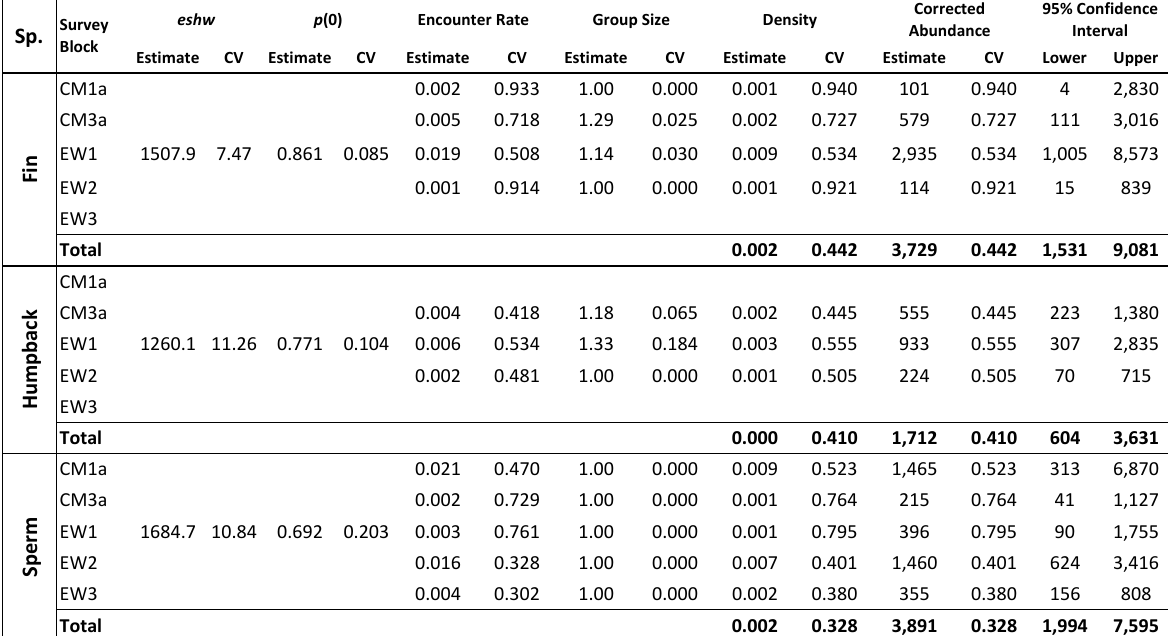
Table 13. Estimated density and abundance of large whale species from the NASS extension survey conducted in 2015. The eshw (effective search half width (m)) and p (0) were estimated for the entire study area. Encounter rate, group size, density, abundance and upper and lower confidence limits were estimated by block and corrected for perception bias, with the estimated p